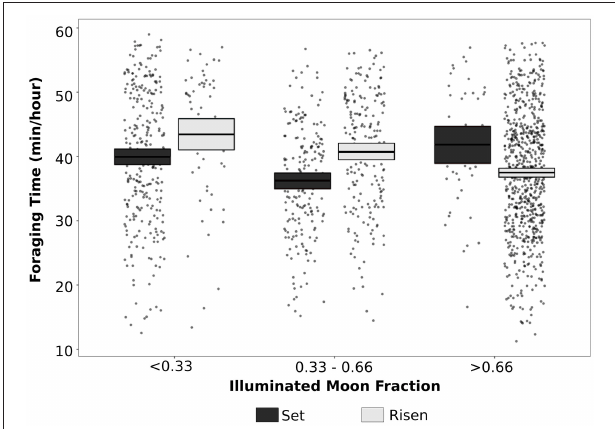
FIGURE 8 | Average foraging time (min/h) of snowshoe hares when moon is above (risen; light gray) or below (set; black) the horizon during different moon illumination fractions (mean ± 95%